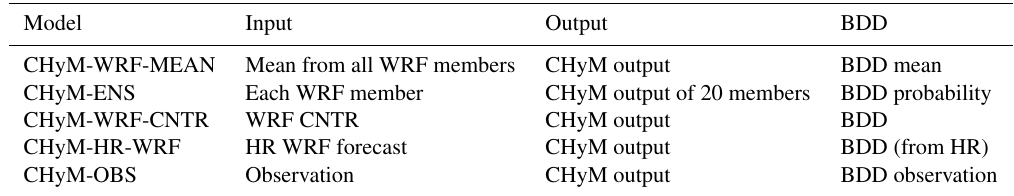
CHyM-OBS Observation CHyM